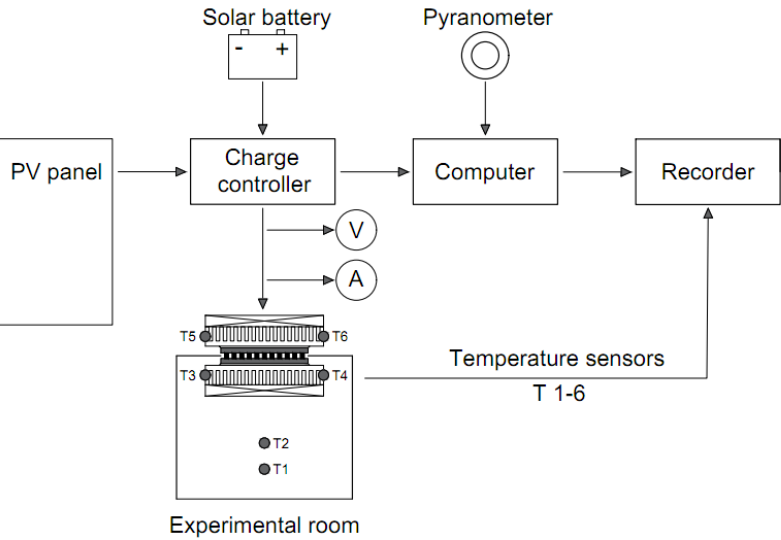
Figure 1. The scheme of the TE module power supply and measurement and recording system in the first stage of experiment including a solar system power supply (PV panel, charge controller and solar battery).